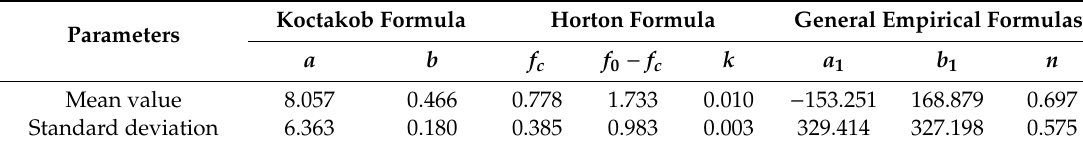
Table 4. Mean value and standard deviation of experiential